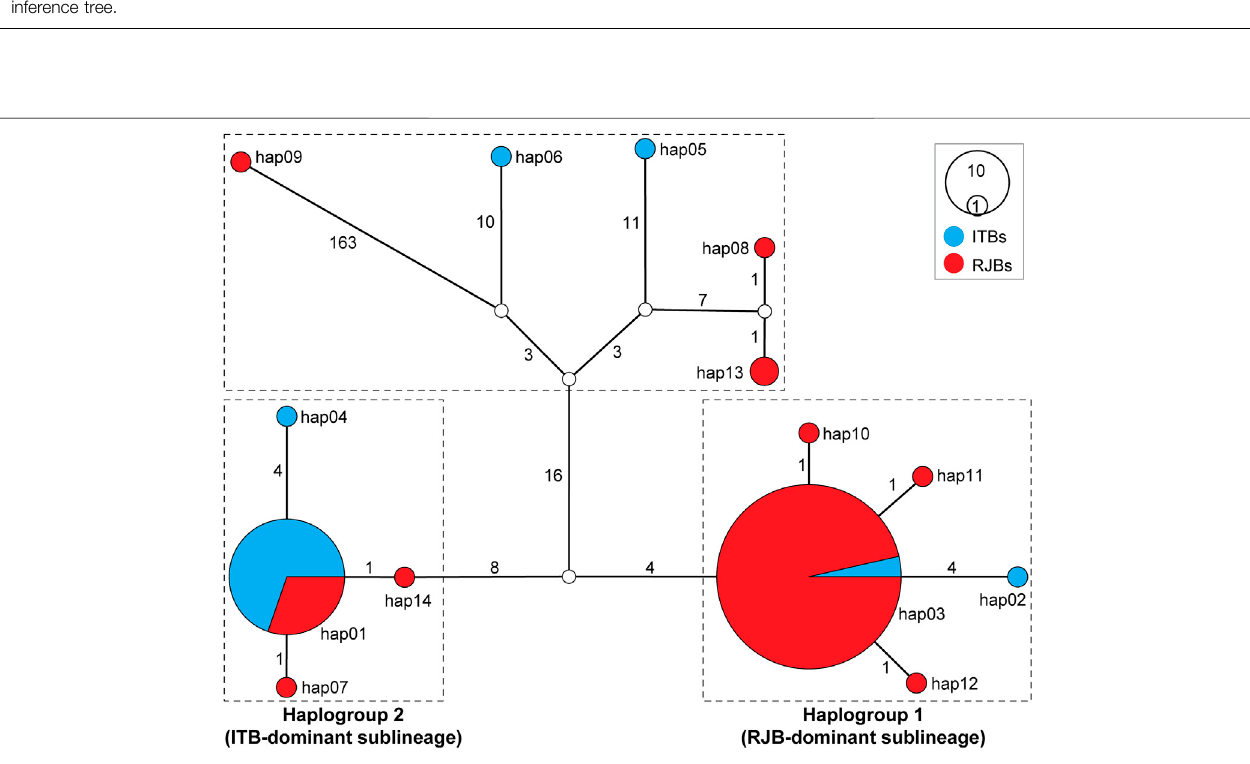
FIGURE 4 | Haplotype network of RJBs and ITBs. The network was inferred from concatenated data of the 37 mitochondrial genes. Circle size is proportional to haplotypefrequency.Emptycirclesrepresenthypotheticalintermediatehaplotypes.Mutationstepsareshownnexttobranches.Twomajorhaplogroupswereidenti fi ed with haplogroup 1 and 2 corresponding to RJB- and ITB-dominant sublineages ( Figure 3 ), respectively.